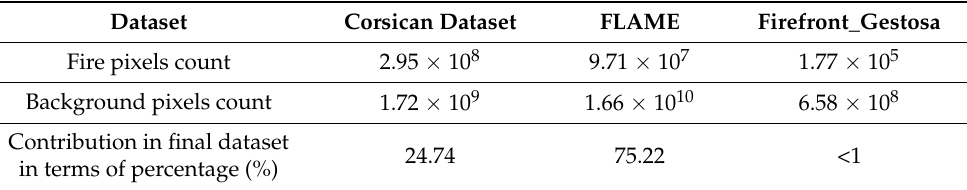
Table 4. The pixel distribution of our final dataset and the fire pixel contribution in terms of